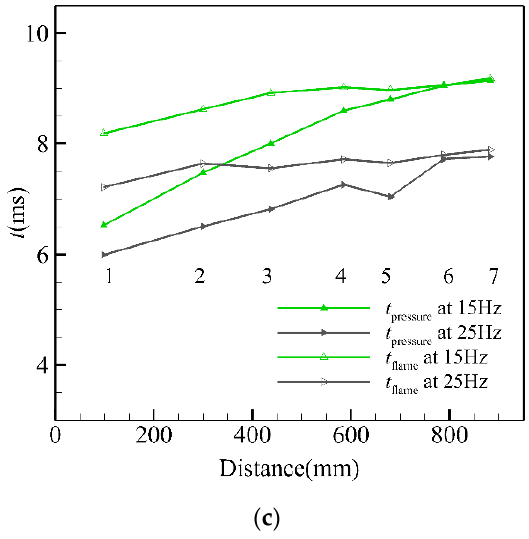
Figure 5. t pressure and t flame at each measuring point of PDC when T t = 288 K. ( a ) t pressure and t flame at measuring point 7 when f = 30 Hz. ( b ) t pressure and t flame at 10 Hz, 20 Hz, 30 Hz. ( c ) t pressure and t flame at 15 Hz, 25 Hz.